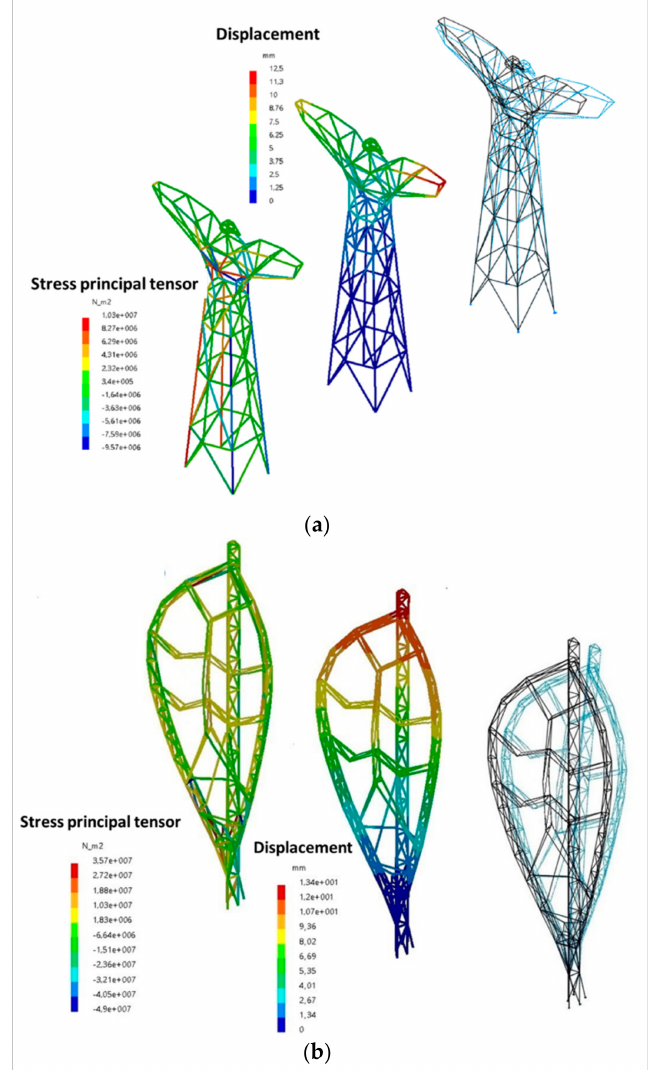
Figure 15. Results of Finite Elements Analysis (FEA) for the final configuration of the eagle ( a ) and sail ( b ) models under one of the load conditions (LC#2).